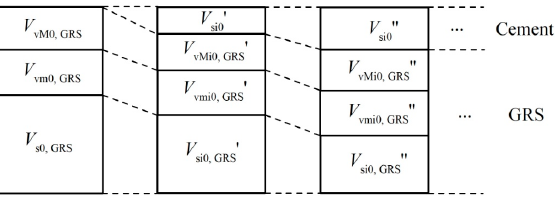
Figure 21. Illustration of volumetric constitutions of an as-compacted specimen with different cement contents.